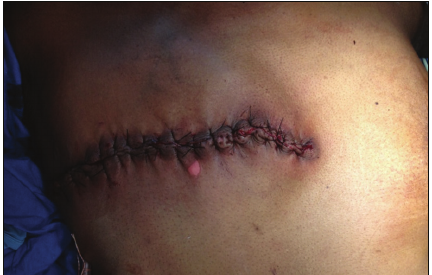
Figure 5: Postoperative picture.